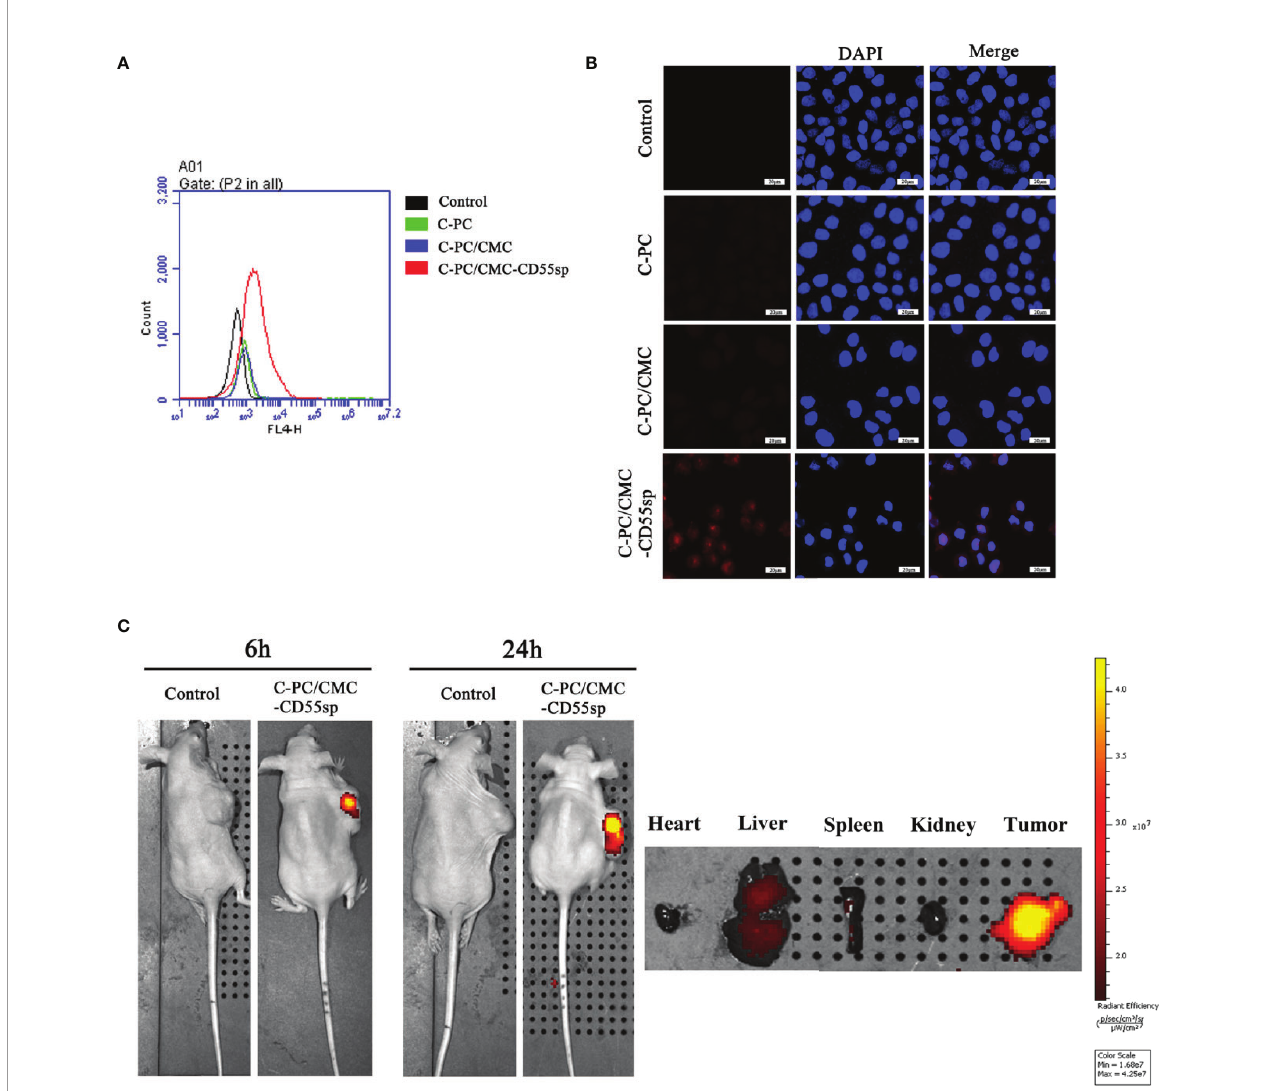
FIGURE 3 | Determination of targeting effects using fl ow cytometry, laser confocal microscopy, and imaging. (A) Flow cytometry analysis. The fl uorescence intensity of HeLa cells was determined using fl ow cytometry. The horizontal axis represents fl uorescence intensity. Fluorescence intensity represented the targeting ability of drugs. (B) Laser confocal microscopy. Fluorescence intensity of HeLa cells was determined using laser confocal. Blue fl uorescence represents nuclei, and red fl uorescence represents targeting ability. (C) Imaging. Fluorescence intensity in tumor tissues and organs (heart, liver, spleen, and kidney) was detected using small animal imaging system. The color scale represents fl uorescence intensity. Fluorescence intensity represents the targeting ability of